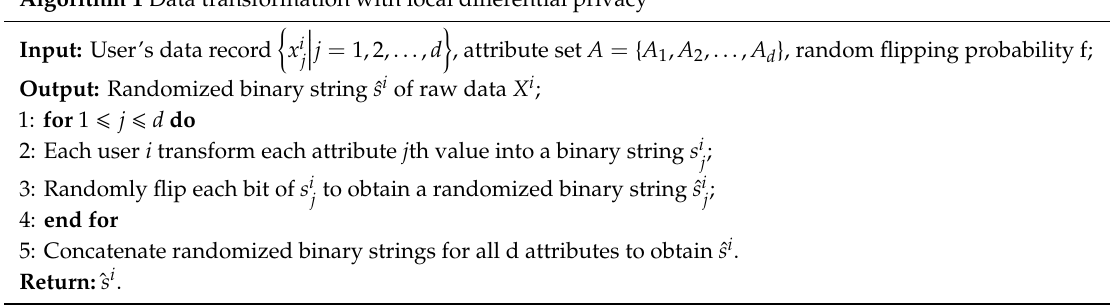
Algorithm 1 Data transformation with local di ff erential